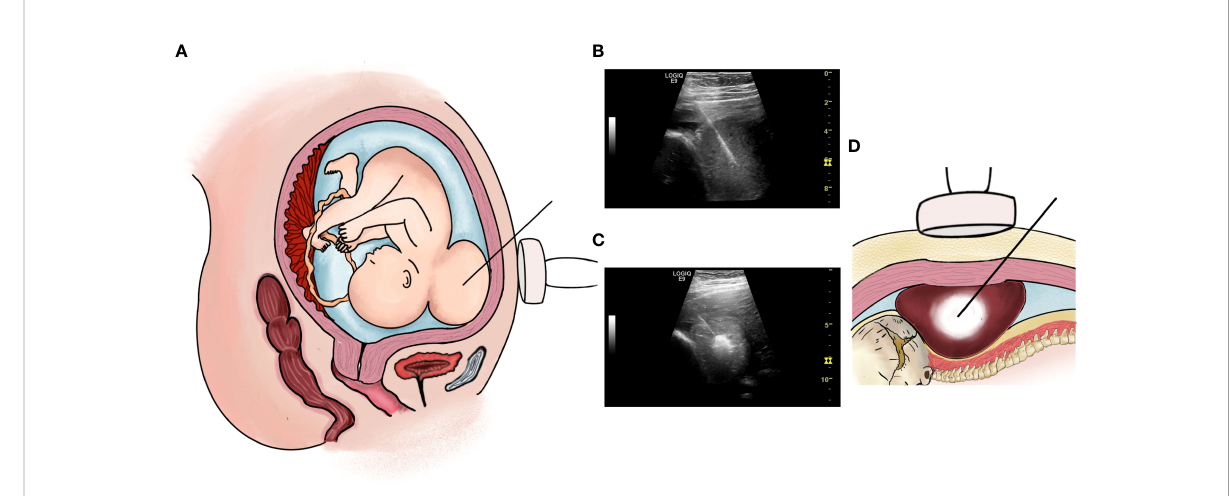
FIGURE 2 (A, B) : Percutaneous intrauterine biopsy at 29+ weeks of gestation. (A) Operation pattern diagram; (B) Percutaneous intrauterine biopsy under ultrasound guidance during operation. (C, D) : RF ablation therapy at 29+ weeks of gestation. (C) Operation pattern diagram; (D) RF ablation therapy under ultrasound guidance during operation.